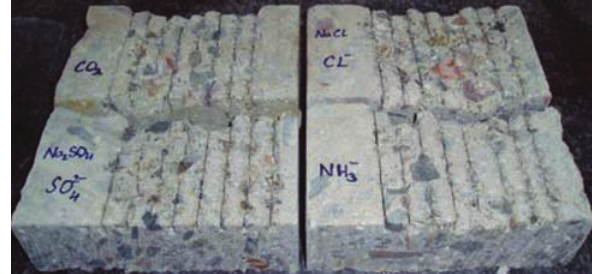
Fig. 2. Selected samples of construction concretes cut in the overpressure vessel by a high-pressure generated water jet